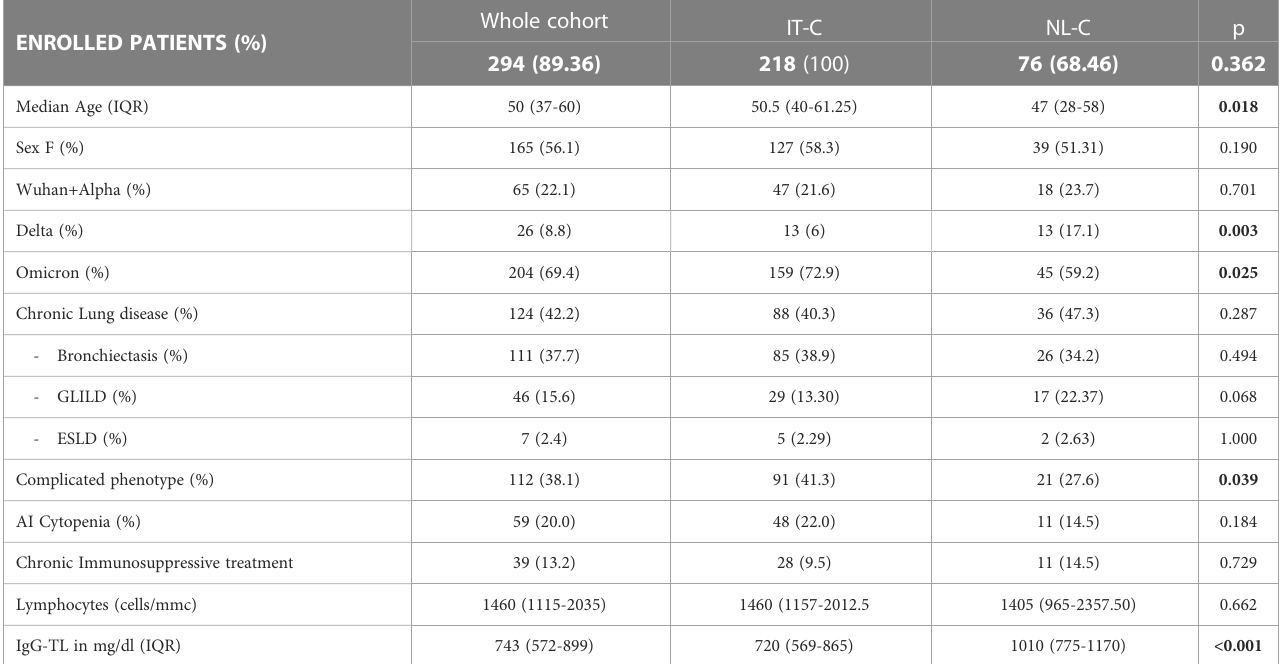
TABLE 1 Demographics and CVID-related information in the whole cohort and in the IT-C and NL-C sub-cohorts.